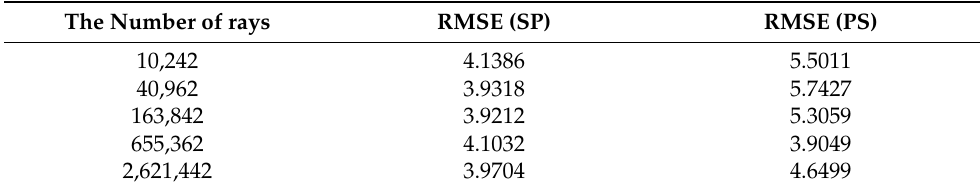
Figure 13. Path loss comparison of theoretical calculation with measured data for 655,362 and 2,621,442 rays in the LOS. ( a ) The number of rays is 655,362 ( b ) The number of rays is 2,621,442. Table 3. The RMSE in the LOS. Table 3. The RMSE in the LOS. The Number of rays RMSE (SP) RMSE (PS)